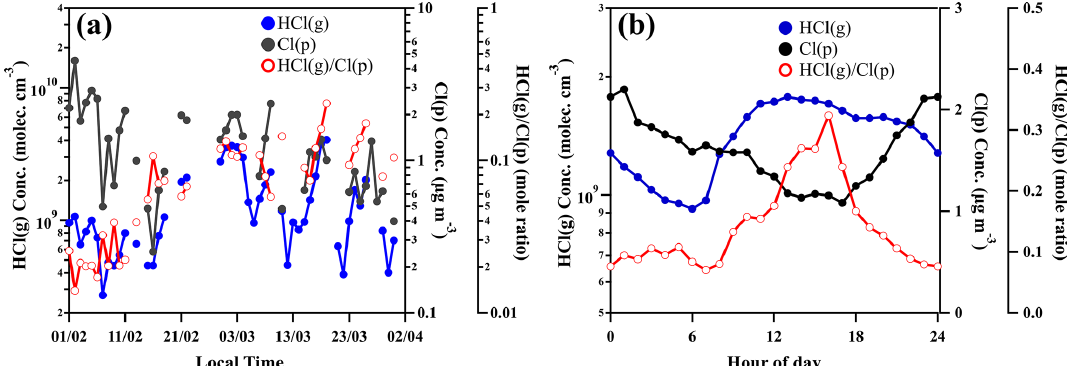
Figure 5. Time variation of daily averaged concentration of particulate chloride (Cl( p )) measured by ACSM, gaseous HCl (HCl( g )) measured by CI-APi-LTOF and mole ratios of HCl( g ) / Cl( p ) (a) and diurnal variation of HCl( g ), Cl( p ) and mole ratios of HCl( g ) / Cl( p ) (b)